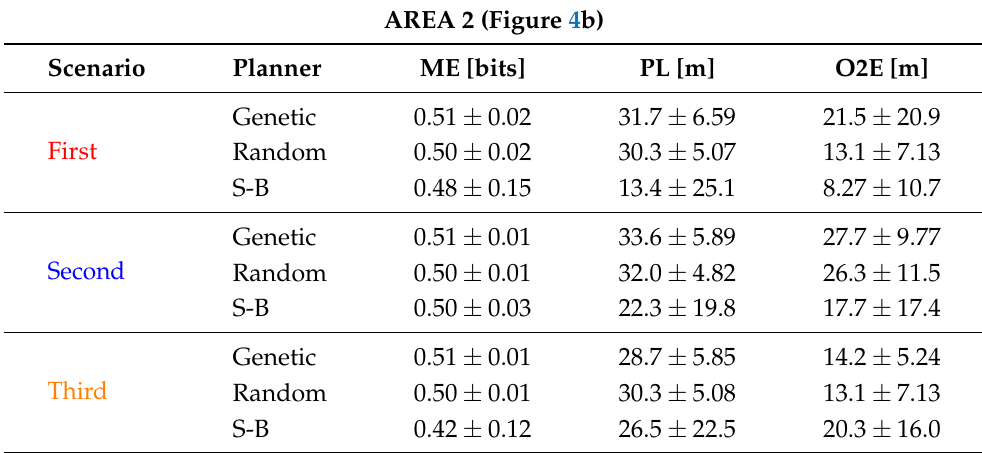
Table 3. Results, in terms of mean and three times the std. dev., of the 3 planners in 3 scenarios of Area